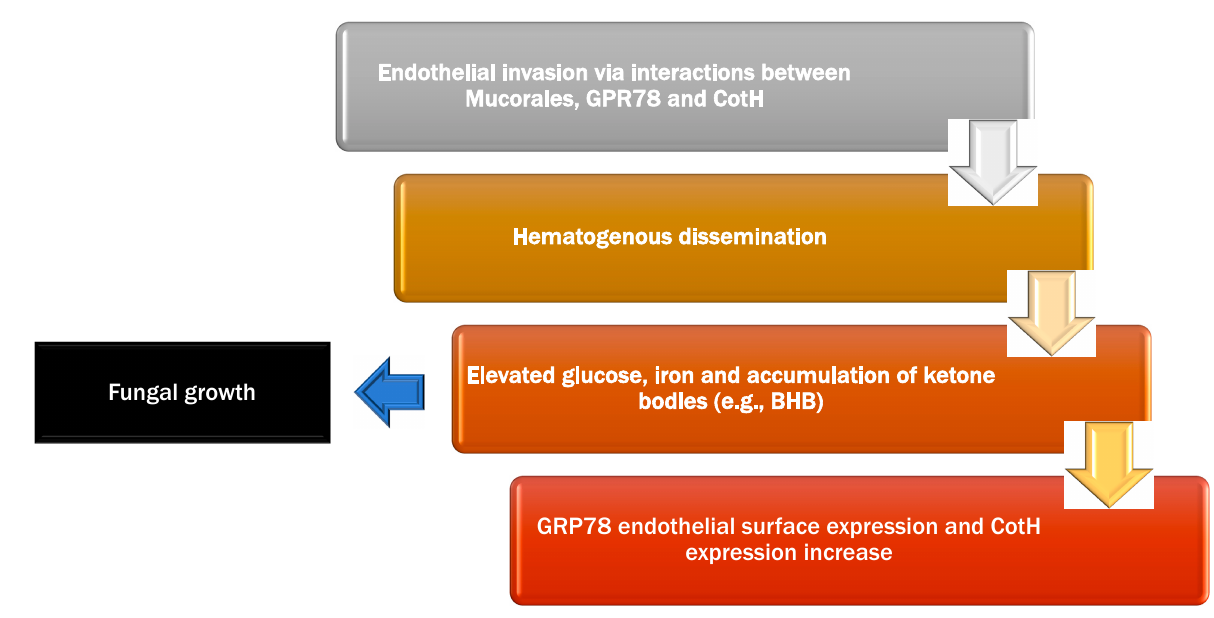
Figure 1. Pathogenesis of mucormycosis. β -hydroxybutyrate (BHB); Glucose regulator protein (GPR78); Spore-coating protein family (CotH).